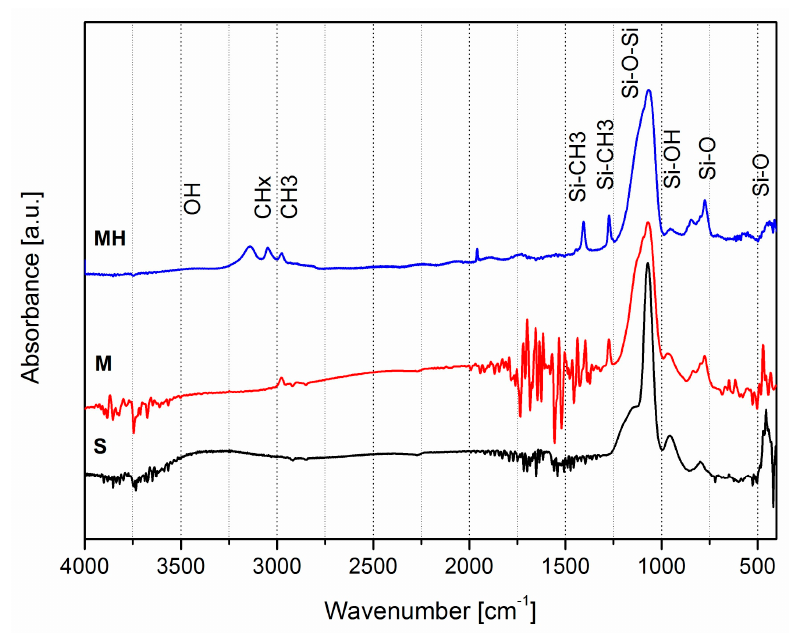
Figure 4. FTIR spectra of coatings obtained from sols S, M and MH.